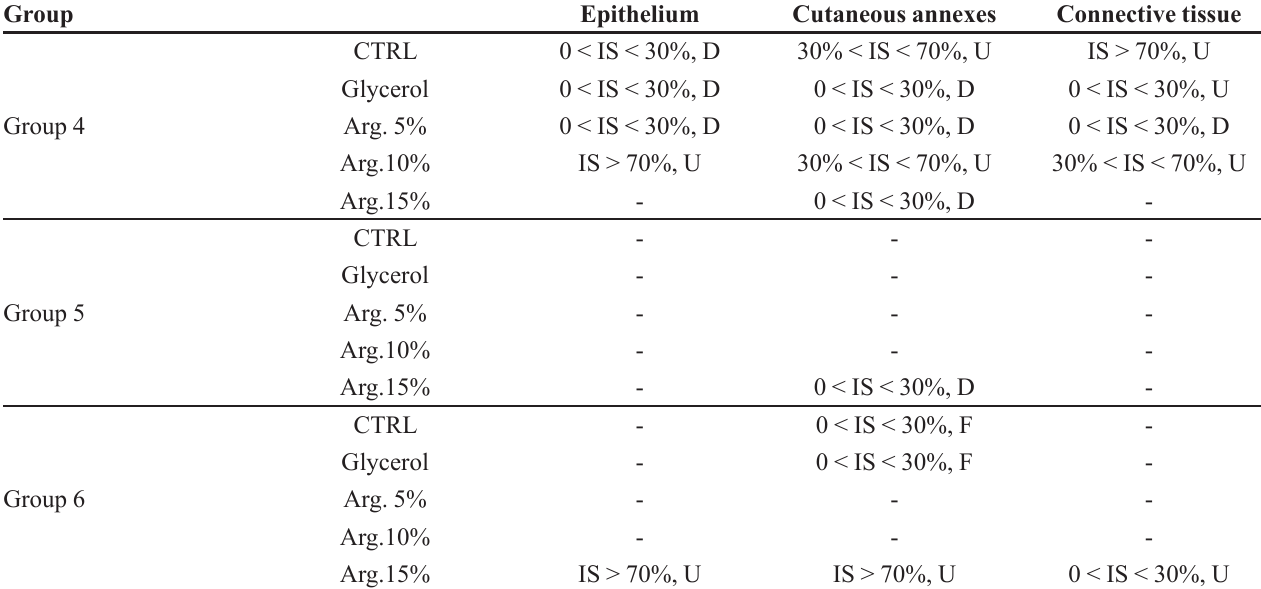
TABLE IV - Immunohistochemical iNOS staining of male mouse skin Group Epithelium Cutaneous annexes Connective